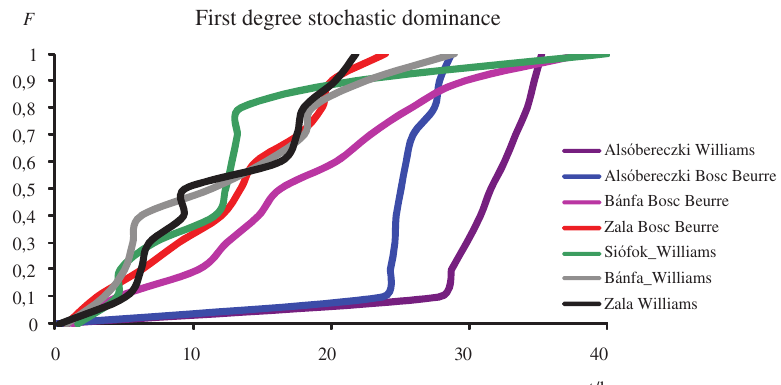
Figure 4. Illustration of first degree stochastic dominance. The distribution functions are for the yield of four different plantations and to ‘Williams’and ‘Bosc Beurre’pear varieties